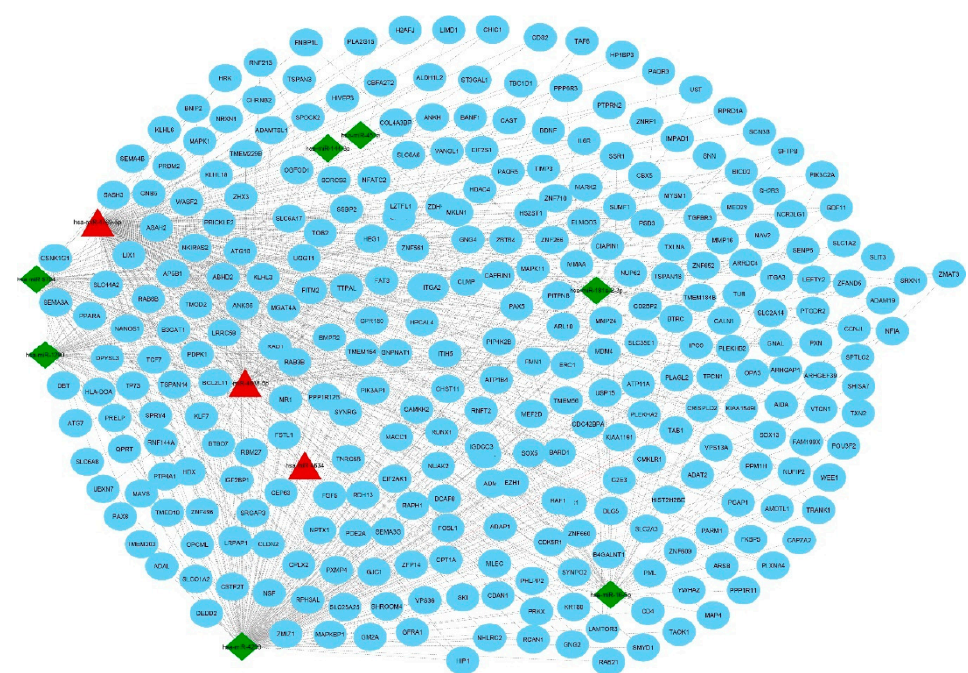
Figure 2. Regulatory network between the top 10 DEMs and their target genes. The target genes were obtained from four di ff erent databases and the common ones proceeded forward. This network contains 317 nodes and 763 edges that were constructed using Cytoscape software. Triangles (red) represent upregulated miRNAs, diamonds (green) represent downregulated miRNAs, and circles (blue) represent genes, as an interacting